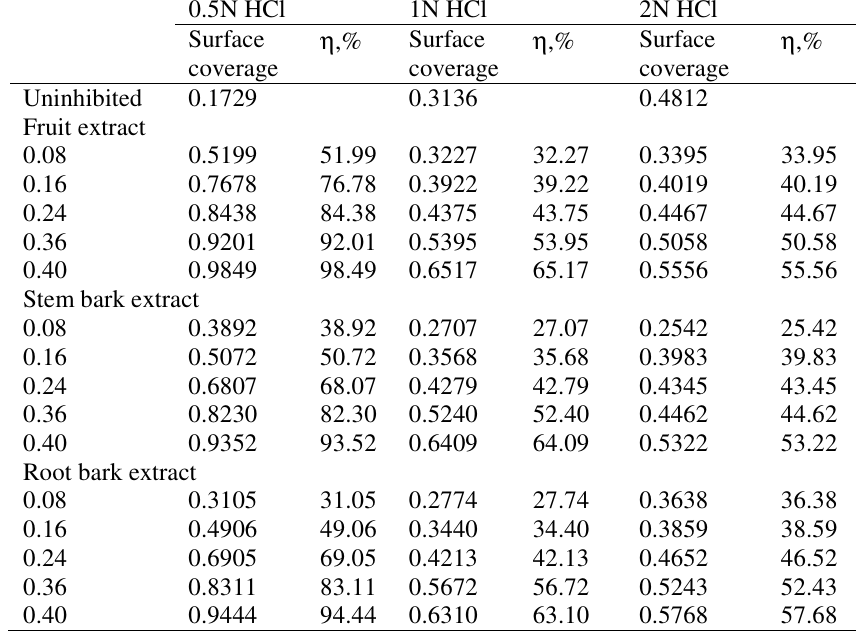
Table 3 . Surface coverage and inhibition efficiency for aluminium in hydrochloric acid solution with given inhibitor addition at room temperature for Capparis decidua